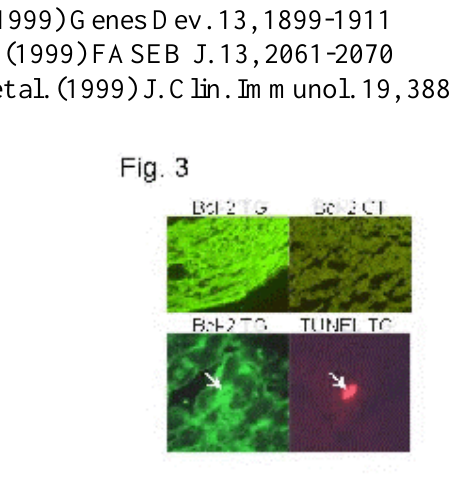
Fig. 3: Mitochondrial DNA mutations lead to cytochrome c release in all cardiomyocytes. Cytochrome c release was monitored as an increase in cyt c immunoreactivity in paraffin-embedded slides. Note the overall increase in cyt c immunoreactivity in the transgenic heart (TG) at 5 weeks-of-age compared to the control heart (CT). As the amount of cyt c in transgenic hearts – either in mitochondria or in whole cell extracts – is at most only slightly higher than controls, we interpret the increased immunoreactivity as an indicator of cyt c release. Importantly, at 3 weeks of age, a patchy cellular pattern of increased immunofluorescence is observed, as would be expected if the rising frequencies of mtDNA mutations need to cross a threshold to induce cyt c release. Given the stochastic mechanism causing mtDNA mutations in this model, not all cells are expected to arrive at that threshold at the same age. By 5 weeks of age, all cells appear to be involved in the disease process. Given the cytotoxicity of released cyt c , cell death remains remarkably in check due to a protective response.